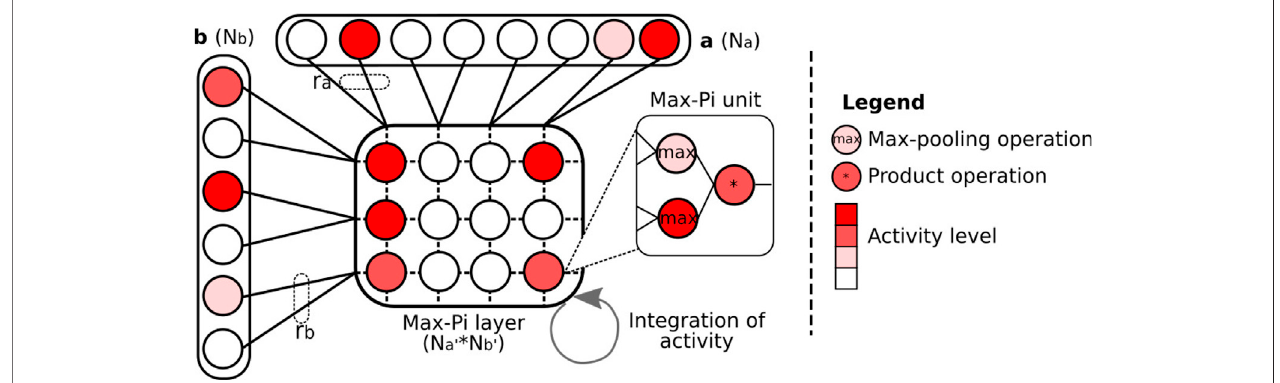
FIGURE 5 | Illustration of the Max-Pi layer (MPL) operation. To merge information coming from two vectors a and b , the MPL performs three operations: a max pooling on r a and r b neurons, a merging on the results of the max pooling via a product, and a temporal integration over a given number of iterations. These operations allow the information coming from vectors a and b to be combined into a compressed activity